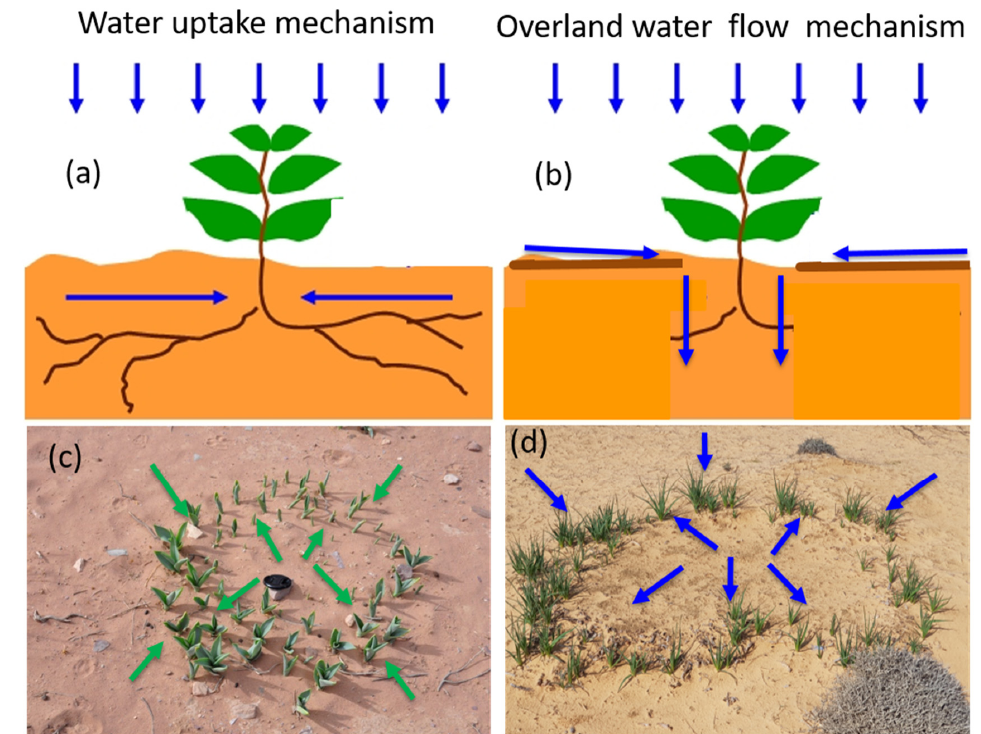
Figure 1. Schematic illustration of the two ring formation mechanisms that are dictated by water competition between individual plants. ( a ) The water uptake mechanism, which is related to the root augmentation feedback. Larger biomass leads to extended roots that can uptake soil water from a larger zone; illustrated by a Urginea maritima ring ( c ). ( b ) The overland flow mechanism, which is attributed to the infiltration contrast between the bare soil (often covered by biocrust) and the plant-covered soil (where biocrust growth is inhibited); illustrated by a Asphodelus ramosus ring ( d ). Surface water flows from the bare soil towards the plant-covered soil, where infiltration is higher. Both mechanisms can lead to ring formation from an expanded spot to in-phase distribution of biomass and soil water, i.e., the soil water is higher under the biomass and lower in the bare soil [11]. According to the vegetation pattern formation theory, rings are localized structures that lack spatial periodic patterns such as gaps or stripes [17]. A ring can be considered a